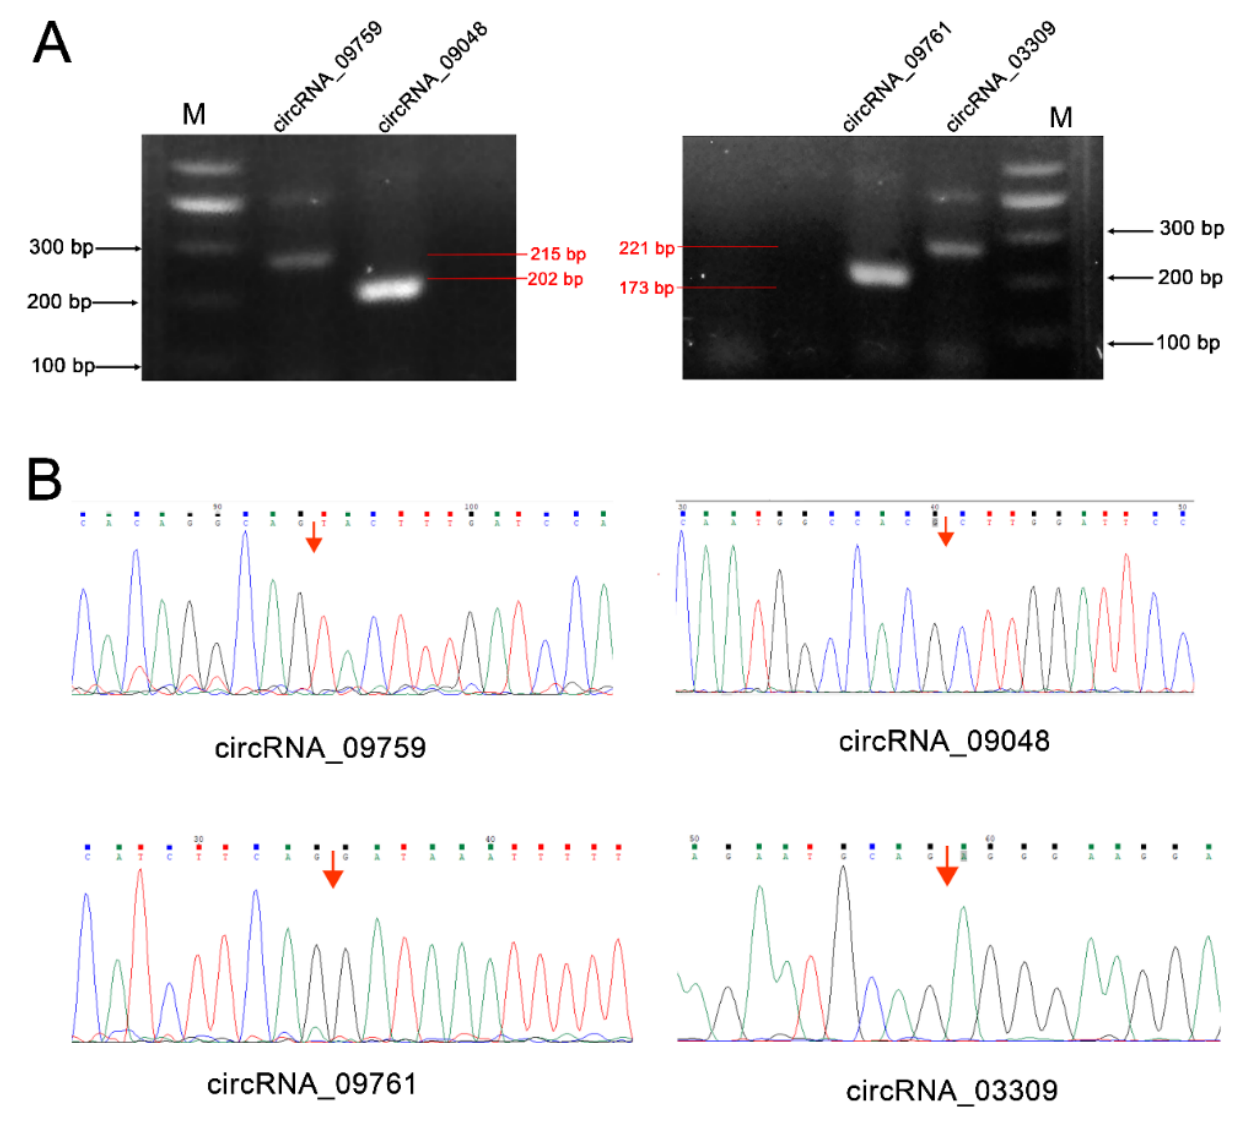
Figure 6. RT-PCR validation of the presence of circRNAs in cow mammary gland tissue. ( A ) Reverse transcriptase-polymerase chain reaction (RT-PCR) amplimers derived from the circular RNAs using divergent primers for cows’ mammary gland RNA (M: marker); ( B ) Head-to-tail splice junctions for the circRNAs were confirmed by DNA sequencing and are marked with a red arrow on the DNA sequence